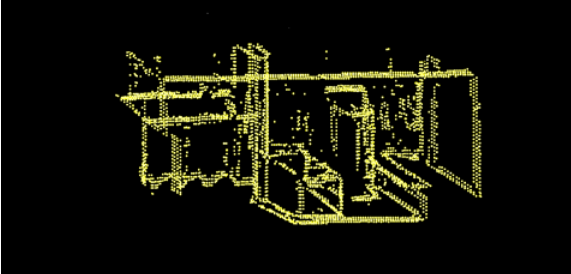
Figure 9. Boundary lines formed by the association of boundary points after the curvature